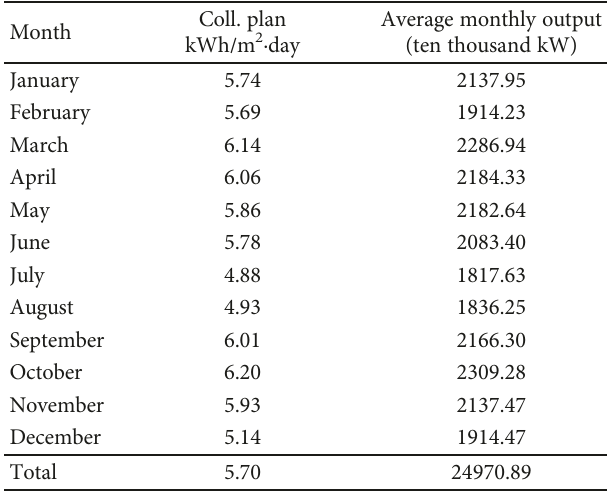
Table 9: Monthly average output based on manual